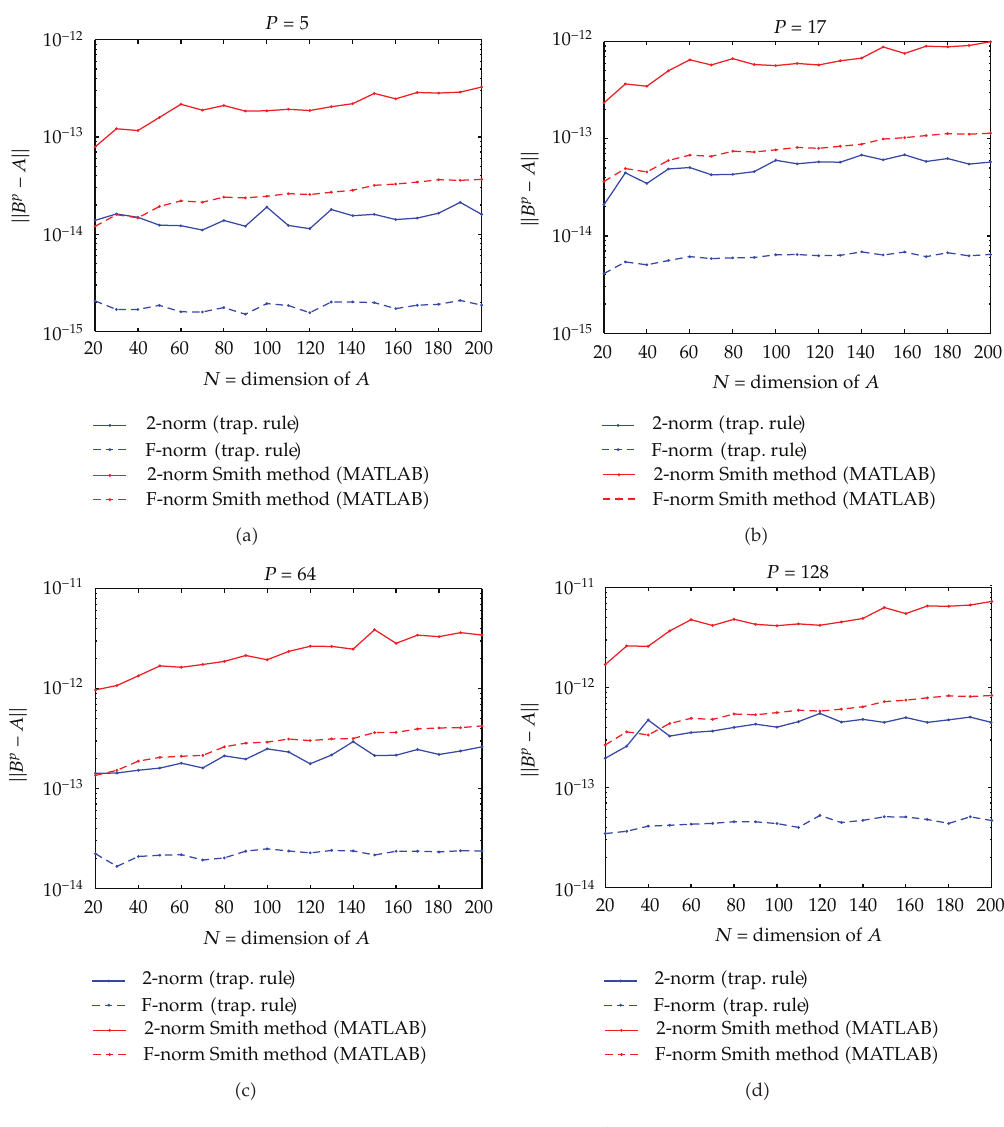
Figure 2: Residual error for computing A 1 /p for Random